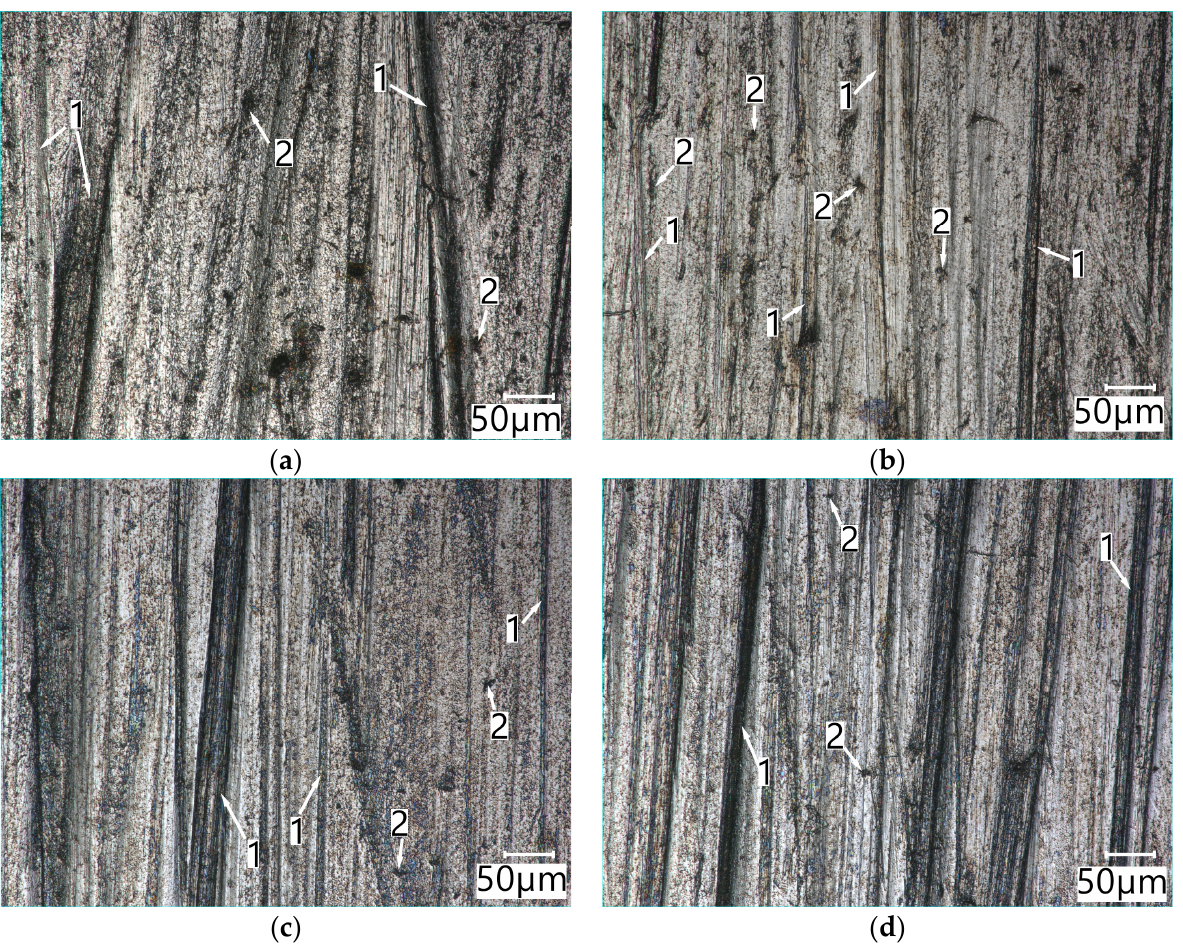
Figure 15. The surface of Vanadis 60 SuperClean (O) and Vanadis SuperClean (W) worn in the medium soil ( a ), ( c ) and light soil ( b ), ( d ): 1 —ploughing, 2 —chipping. Optical light microscopy.